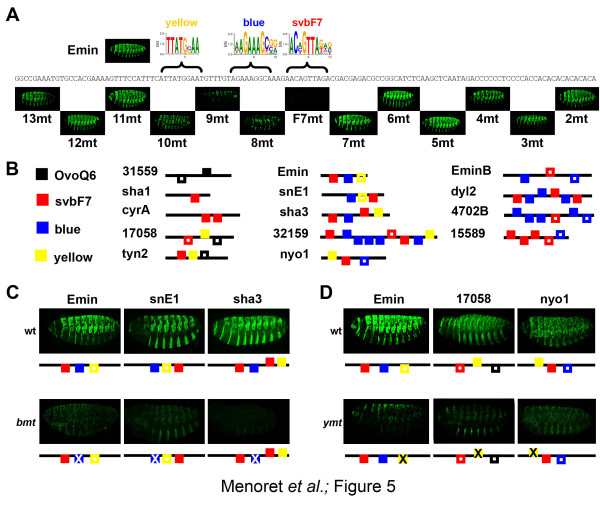
Svb-dependent enhancers use various combinations of cis-regulatory elements. (a) Linker-scanning mutagenesis of Emin identifies other 10 bp regions required for full transcriptional activity, as deduced from altered patterns of lac-Z immuno-staining (green). Positions of SvbF7, blue and yellow motifs are indicated at the top. (b) Black, red, blue and yellow boxes schematize the distribution, number and orientation of OvoQ6, svbF7, blue and yellow motifs, respectively. Filled boxes represent motifs conserved across Drosophila species, open boxes those detected only in D. melanogaster. (c) Point mutations that disrupt the blue motif in Emin, snE1 and sha3 reduce the activity of all three enhancers, to 40 ± 14% (P < 0.03), 44 ± 6% (P < 0.001), 8 ± 4% (P < 0.001) of wild-type (wt) levels, respectively. (d) Point mutations that disrupt the yellow motif in Emin, 17058 and nyo1 reduce the activity of all three enhancers, to 20 ± 7% (P < 0.03), 16 ± 8% (P < 0.03), 6 ± 3% (P < 0.03) of wild-type levels, respectively.